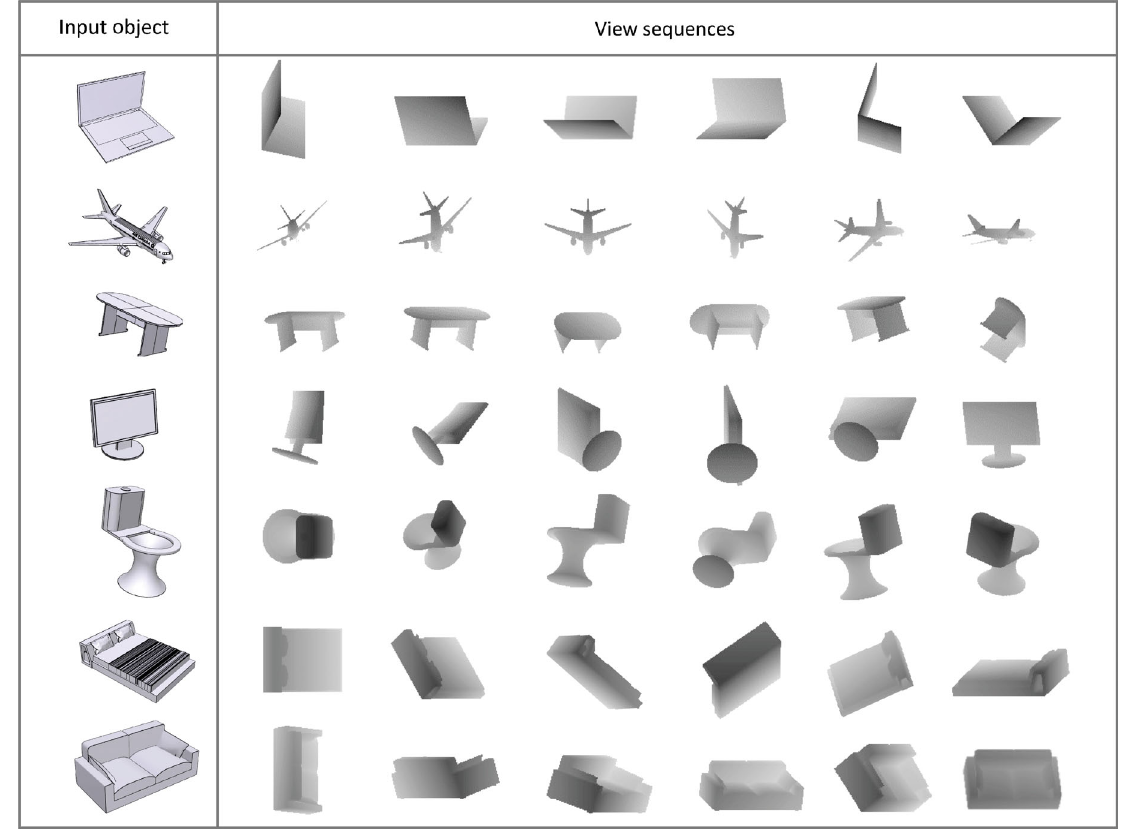
Fig. 8 Visualization of the active recognition process by showing the NBV sequence with depth images for input objects from